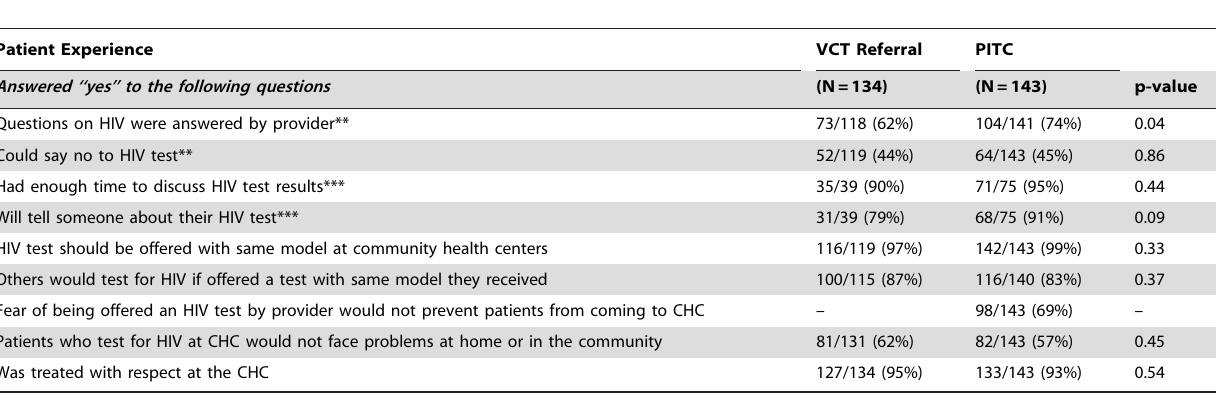
Table 3. Post-test patient experience and perceptions of HIV testing among those referred to VCT or offered a test by their provider (PITC), by testing